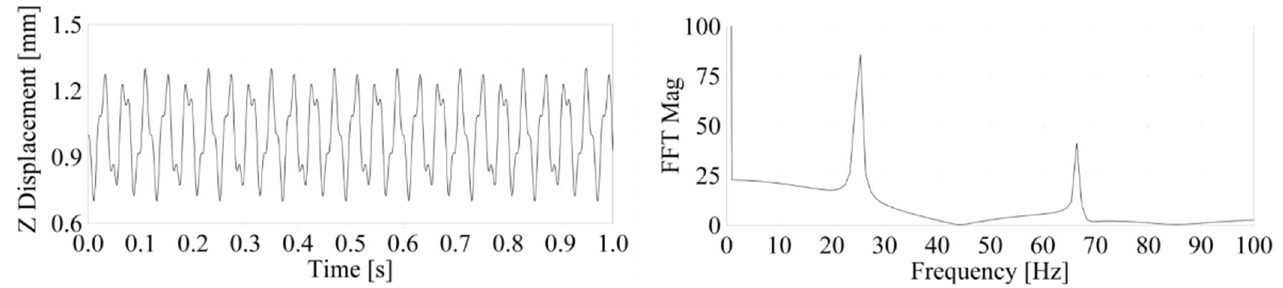
Figure 5. Linear FE model time response ( left ) and FFT response ( right ).